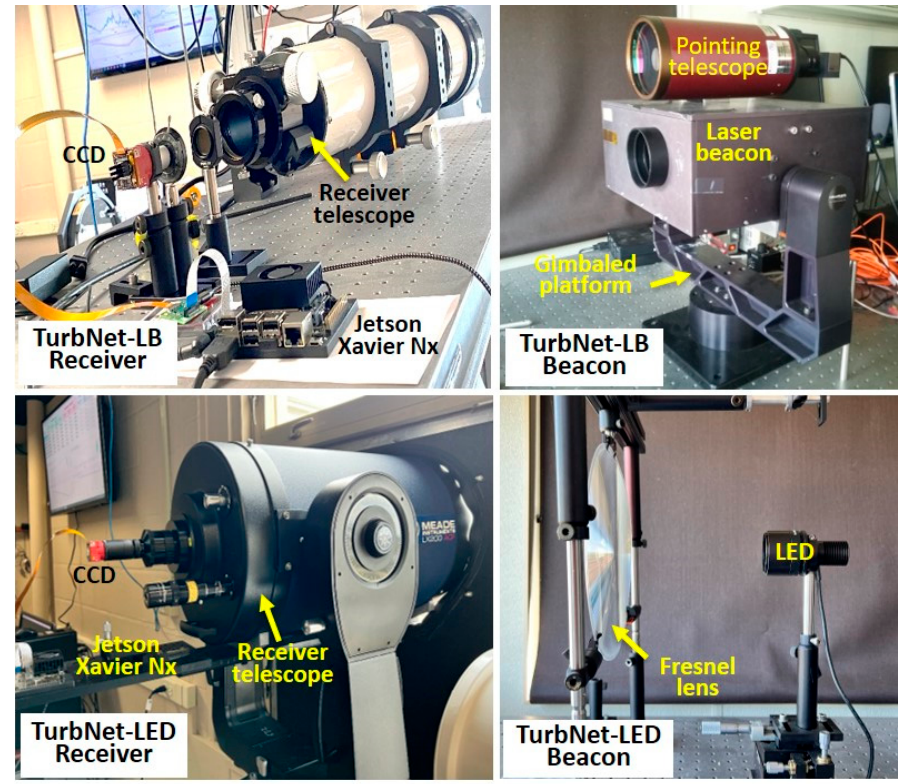
Figure 1. Schematic of the experimental setup used for TurbNet sensor development and evaluation. The laser/LED beacon modules and scintillometer transmitter were located inside an instrumental installation on the 40-m-high roof of the VA Medical Center (VAMC) in Dayton, Ohio. Optical receiver modules of both the TurbNet sensor and the scintillometer were installed directly behind the window inside the UD Intelligent Optics Laboratory (UD/IOL). Locations of EO modules are indicated by arrows. Insert shows the propagation path altitude profile. This experimental setting is described in more detail in [8]. Both data collection and inference experiments were performed using side-by-side C 2 n measurements with a commercial (Scintec BLS 2000 [21]) scintillometer serving as “ground truth” C value reference. The Jetson Xavier Nx AI computer was used for DNN-based C 2 n value prediction.